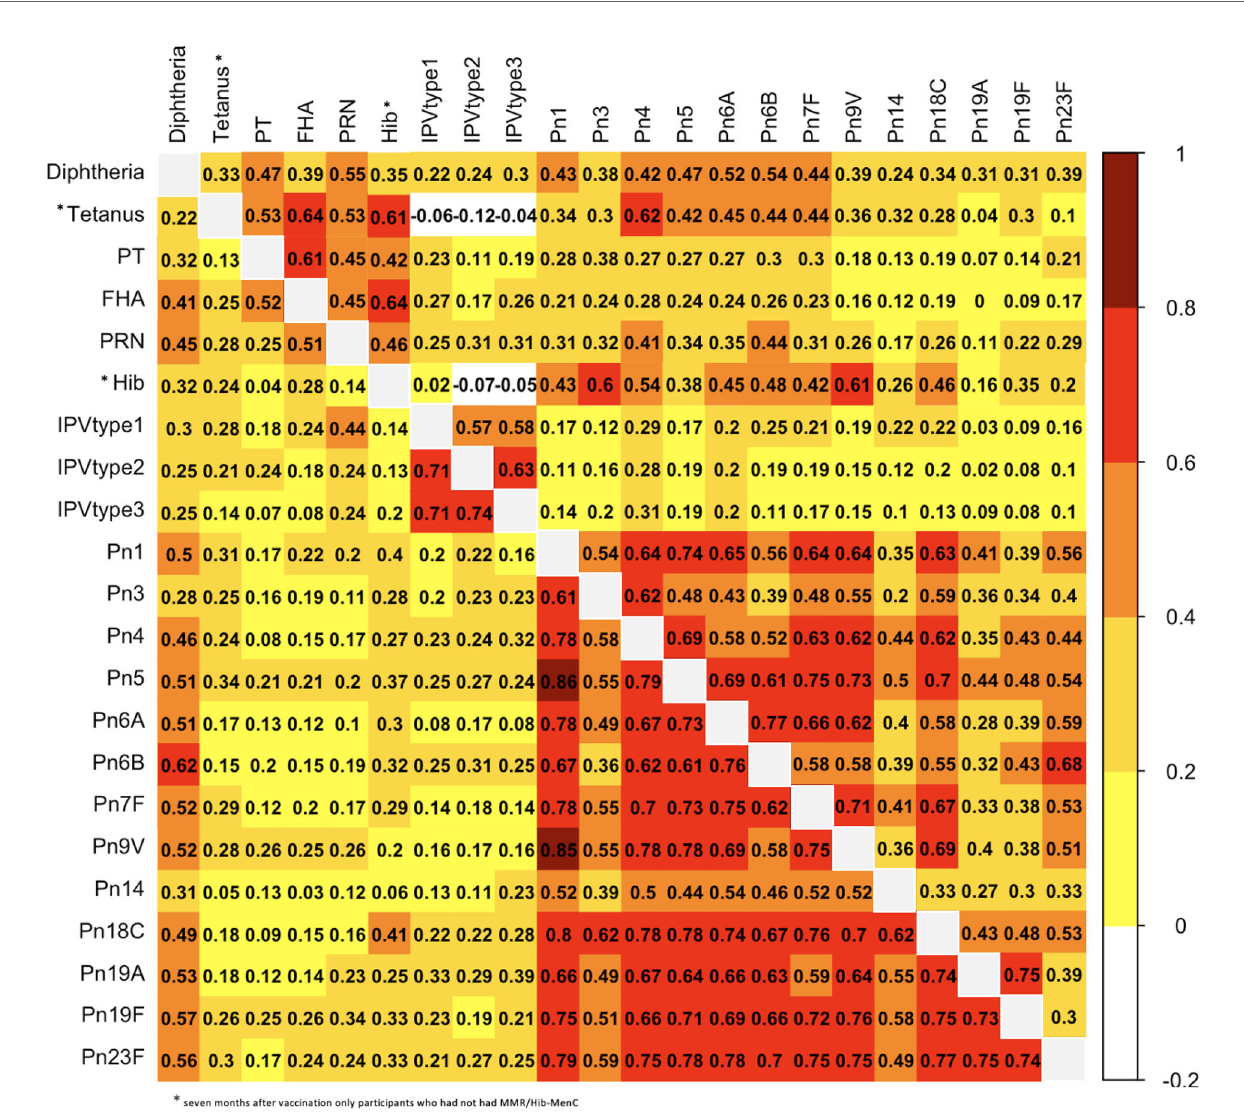
FIGURE 4 | Correlation (expressed as Spearman correlation coef fi cients) for pairwise comparisons of antibody responses to the 6-month vaccinations measured at one (lower left) and seven (upper right) months after vaccination. PT, pertussis toxin; FHA, fi lamentous haemagglutinin; PRN, pertactin; Hib, Haemophilus in fl uenzae type b; IPV, polio; Pn, pneumococcal